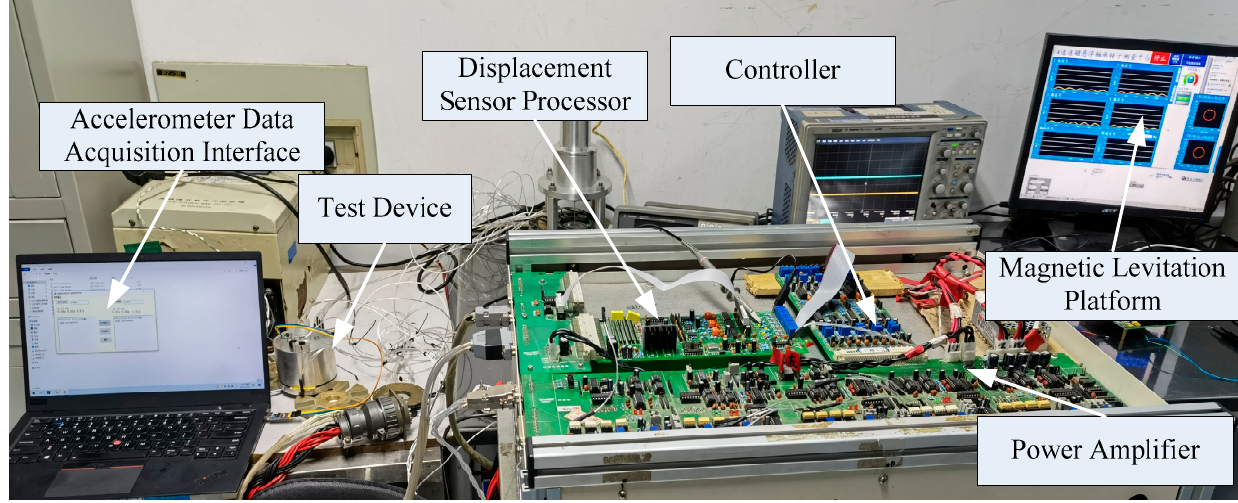
Figure 15. Test device and signal acquisition.